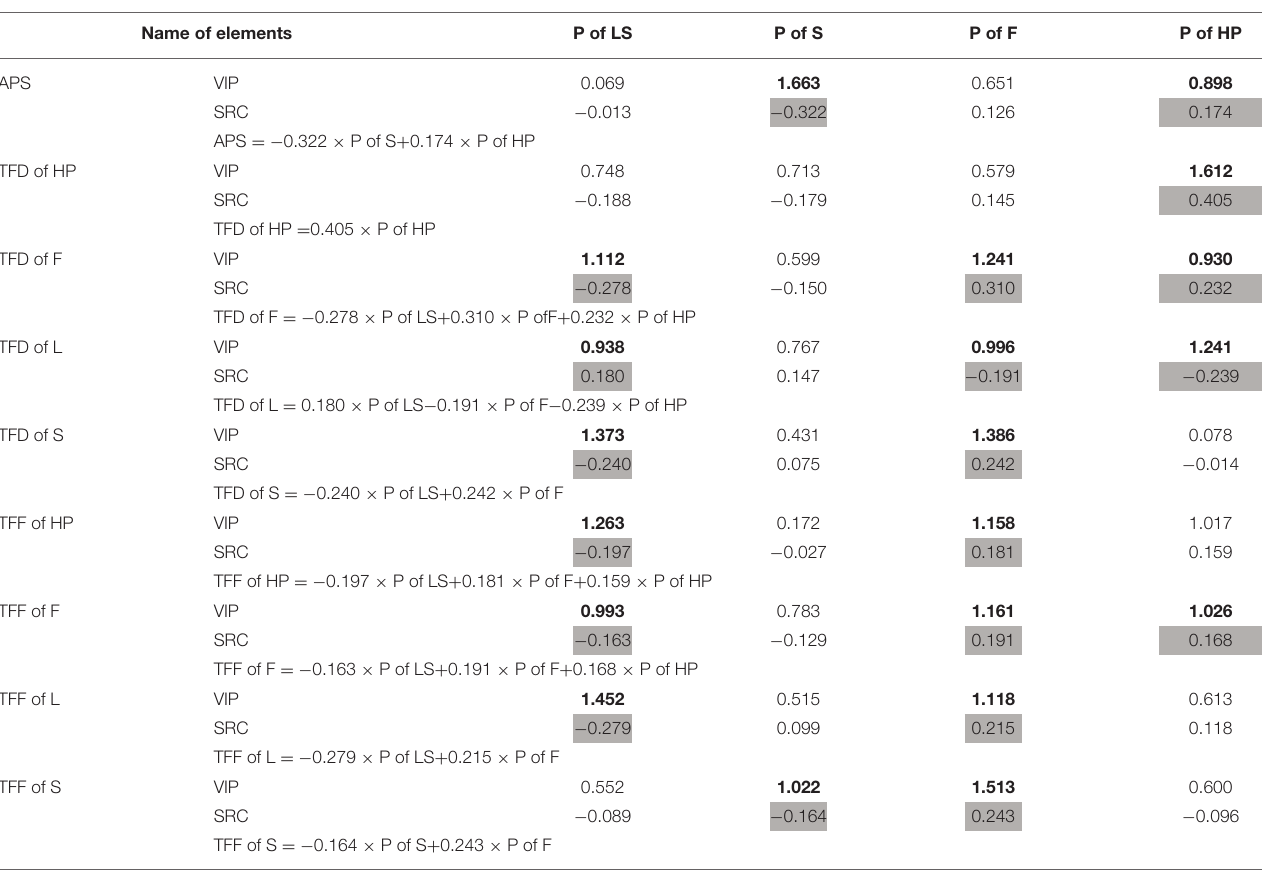
TABLE 8 | Partial least squares regression between EMM and the proportion of space